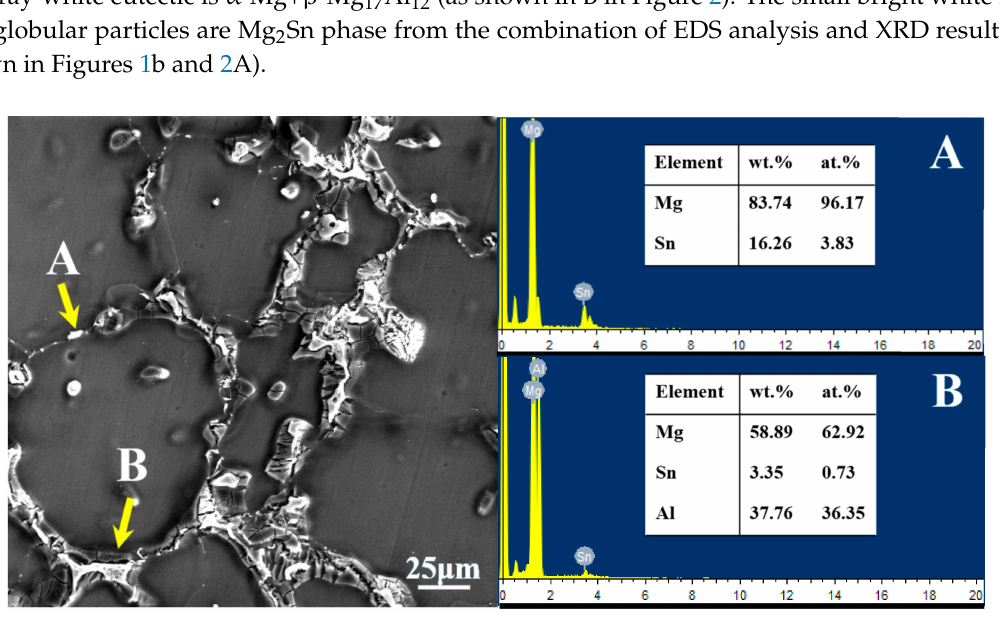
Figure 2. The Energy dispersive spectrometry (EDS) results of the main phase in the as-cast AT63 alloy. ( A ) Mg 2 Sn; ( B ) Mg 17 Al 12